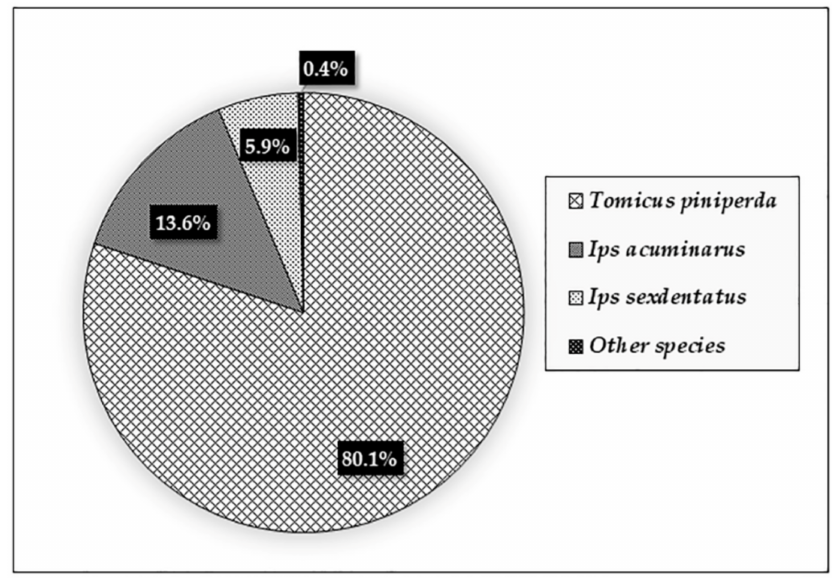
Figure 6. Relative proportions of damage caused by bark beetles in pine plantations of SF Kirkovo during the period 2011–2020.